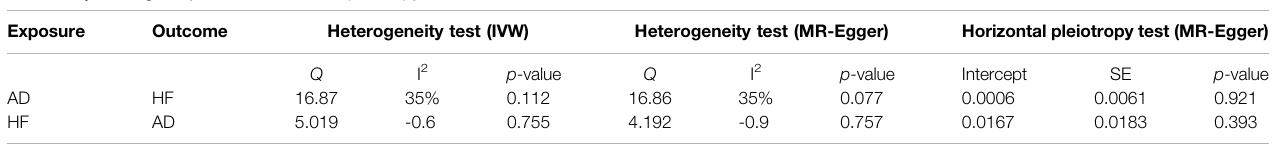
TABLE 3 | Heterogeneity test and horizontal pleiotropy test.